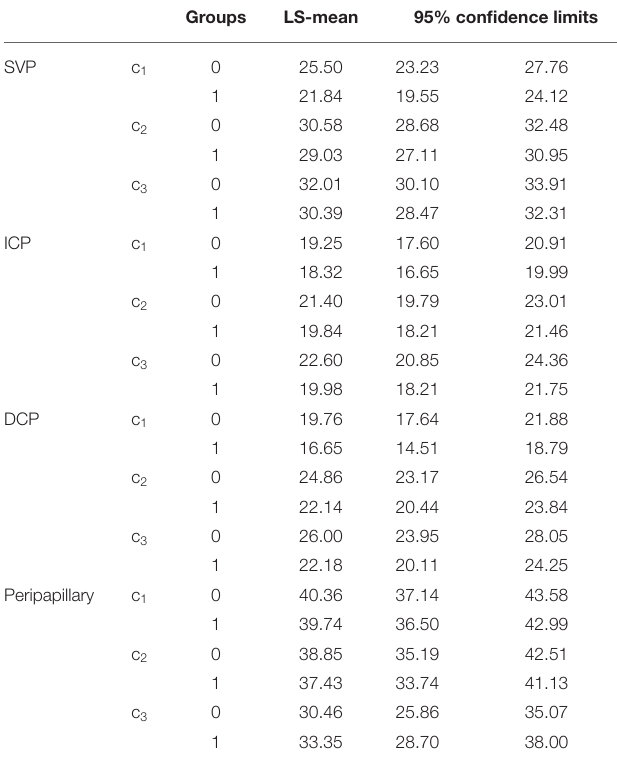
TABLE 3 | Long-term effect of COVID-19 infection on circular vessel density (c 1 , c 2 , and c 3 ) of SVP, ICP, DCP, and peripapillary region between hospitalized (coded as 1) and non-hospitalized (coded as 0) patients: LS-mean, 95% confidence limits.